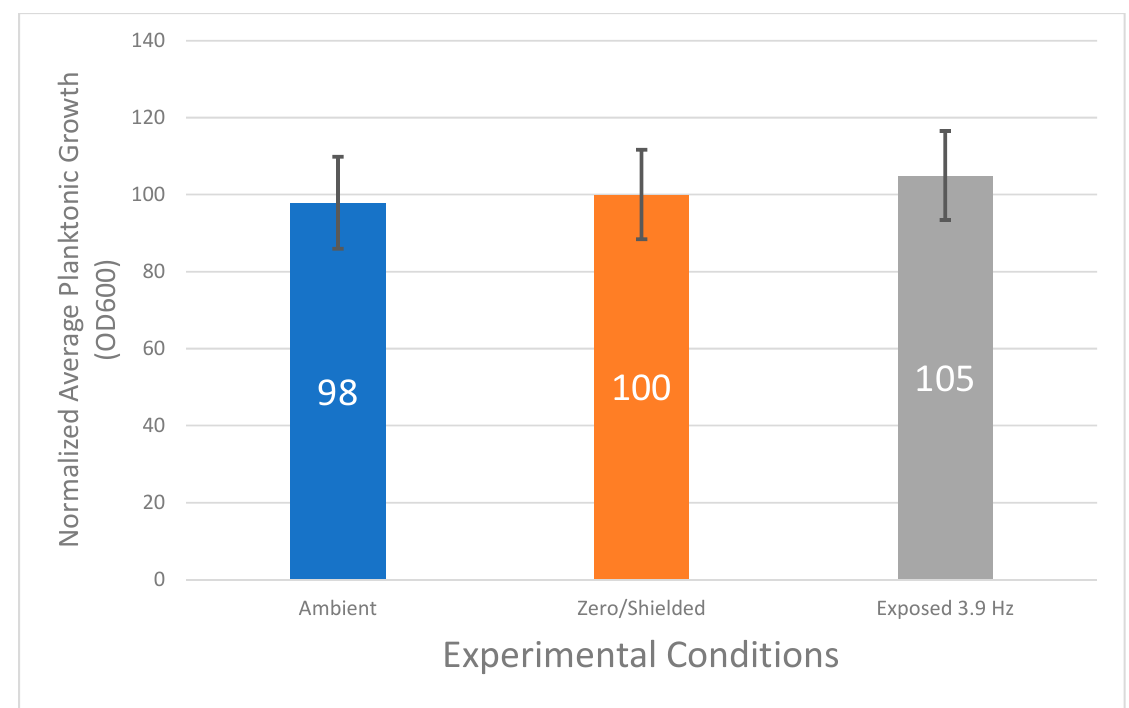
Figure 2. Effect on planktonic bacterial growth (measured as optical density at 600 nm/OD600) for three different growth conditions, “Ambient/room”, “Zero/shielded”, or “Exposed/3.9 Hz”. Y-axis show normalized OD600 values relative to the “Zero/shielded” condition (value 100) for each series. Average and error bars are for n = 2 (Ambient), n = 5 (Zero), or n = 5 (Exposed) experimental series, respectively.